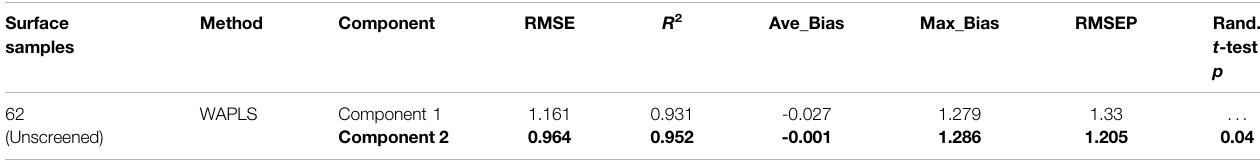
TABLE 2 | Comparison ofthe performanceof diatom water depth (WD)transfer function constructed using WAPLS-Component 1 and Component2 in predicting changes in water depth. Surface